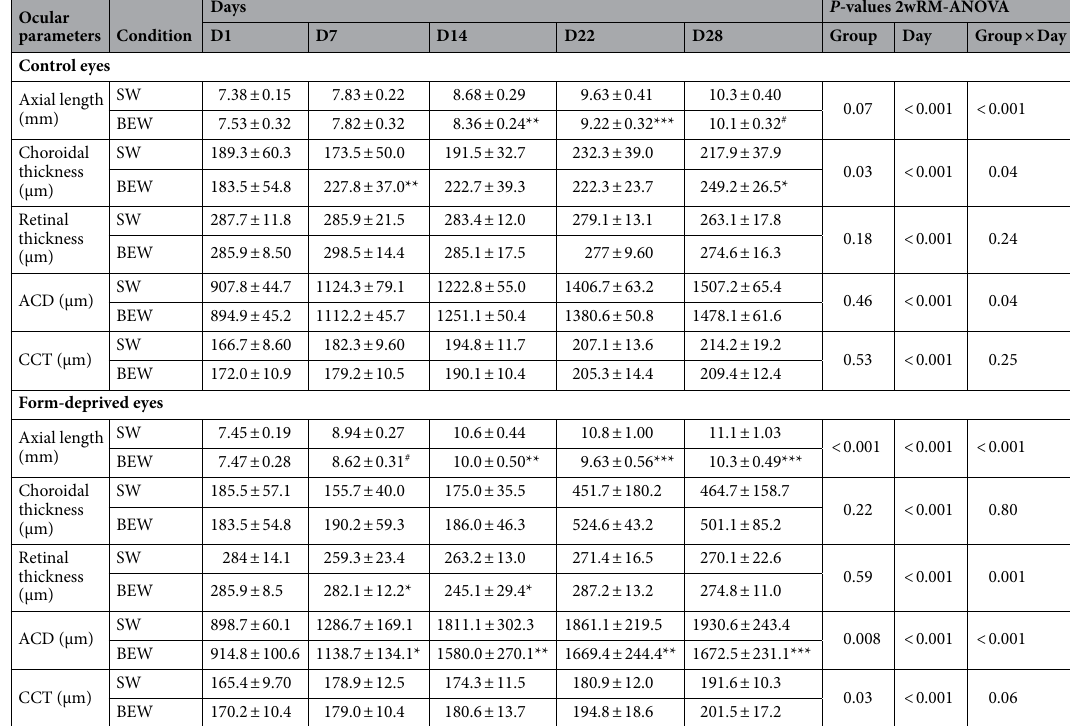
Table 2. In vivo ocular measurements in control and form-deprived eyes exposed to standard white (SW) or blue enriched white (BEW) light. Data are presented as average ± SD. P -values represent the significance of the two way repeated measures ANOVA (2wRM-ANOVA) for “group”, “day” and “group × day” comparisons. Post hoc comparisons using Holm Sidak method are shown in this table for “group x day” interactions